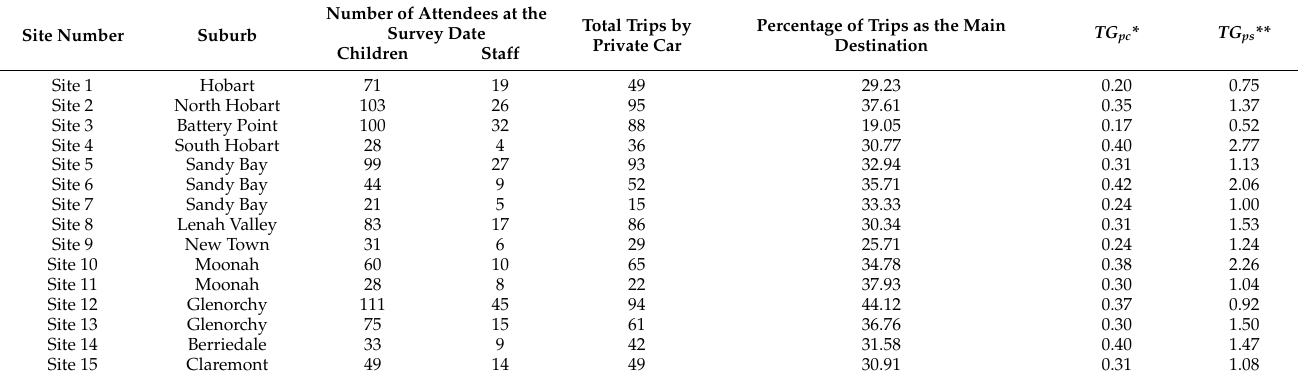
Table 3. Final dependent variables for use in model